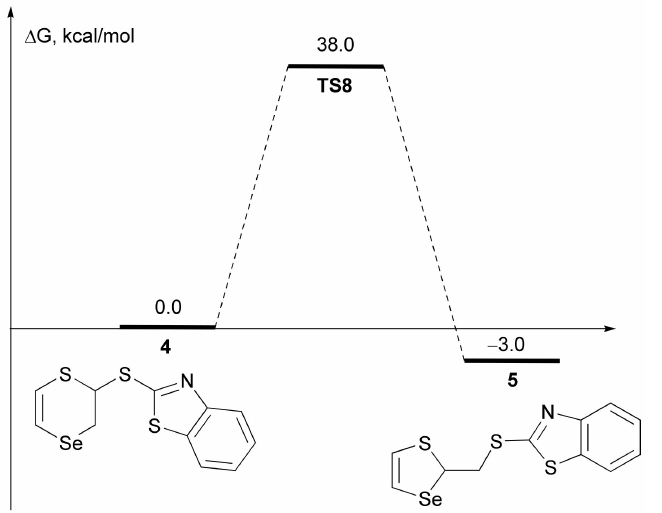
Figure 4. Schematic representation of the process of intramolecular rearrangement 4 → 5 according to B3LYP/6-311 +